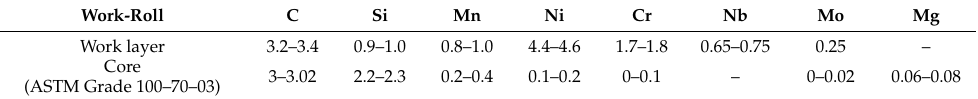
Table 1. Range of chemical composition of the outer layer and of the core (wt.